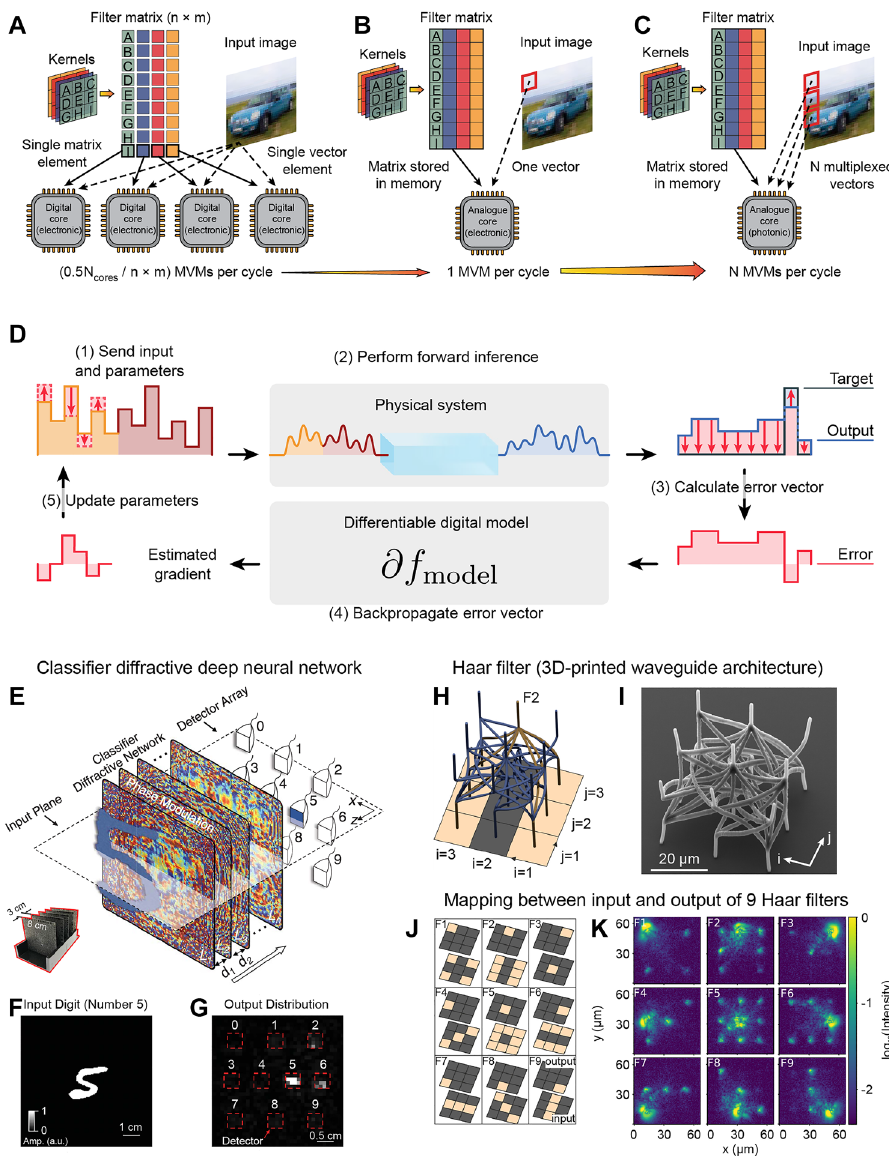
Figure 8: Deep learning with physical